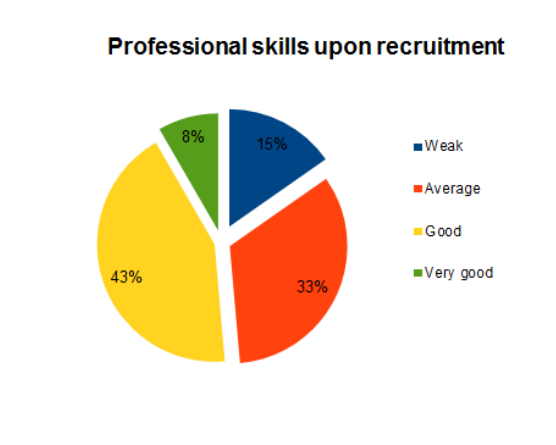
Figure 16 - The level of professional skills upon recruitment at the current place of